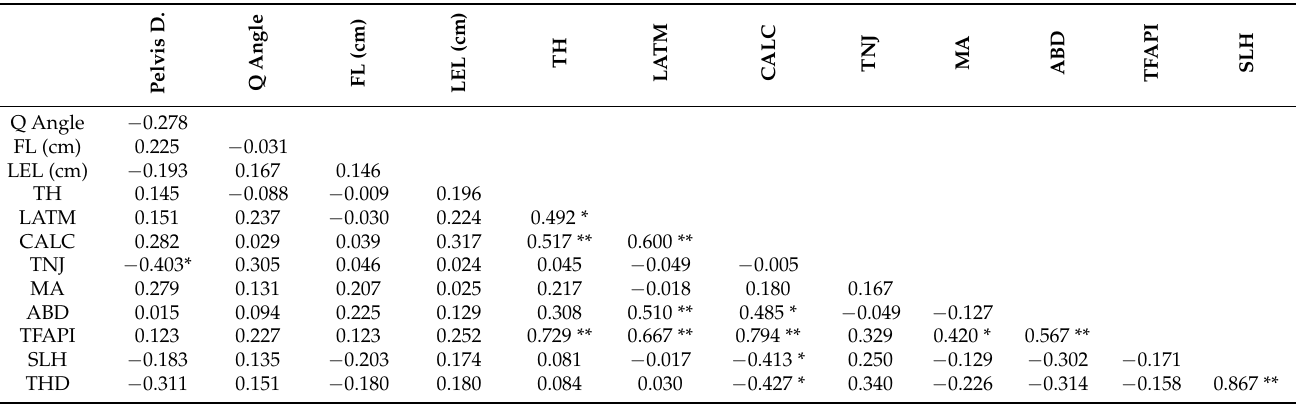
Table 6. Correlation between pelvis diameter, Q angle, foot posture index, lower extremity length, and single hop test on the non-operated